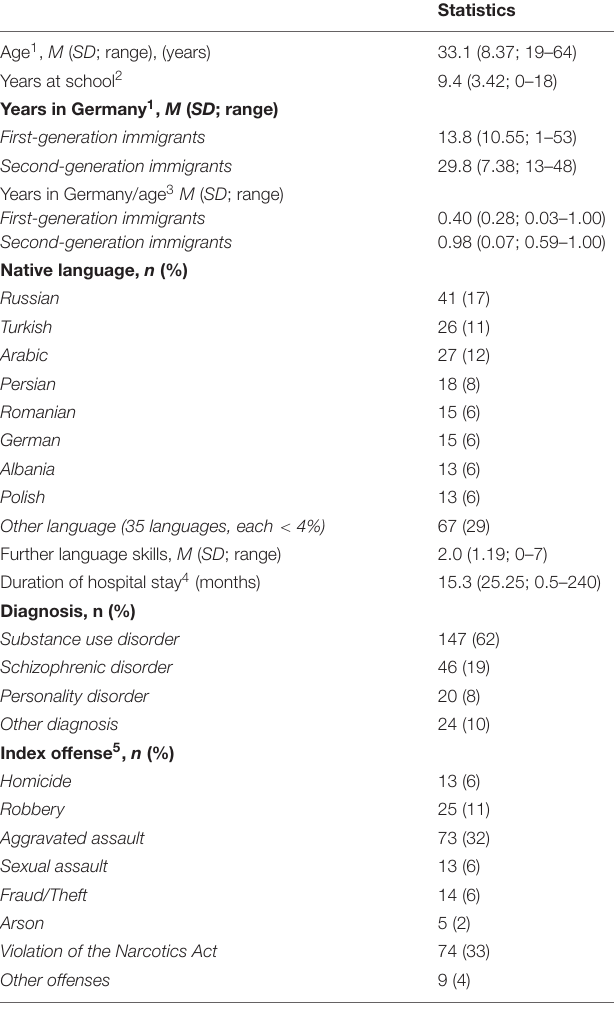
TABLE 1 | Sociodemographic and forensic-psychiatric characteristics of the participants with a migration background.